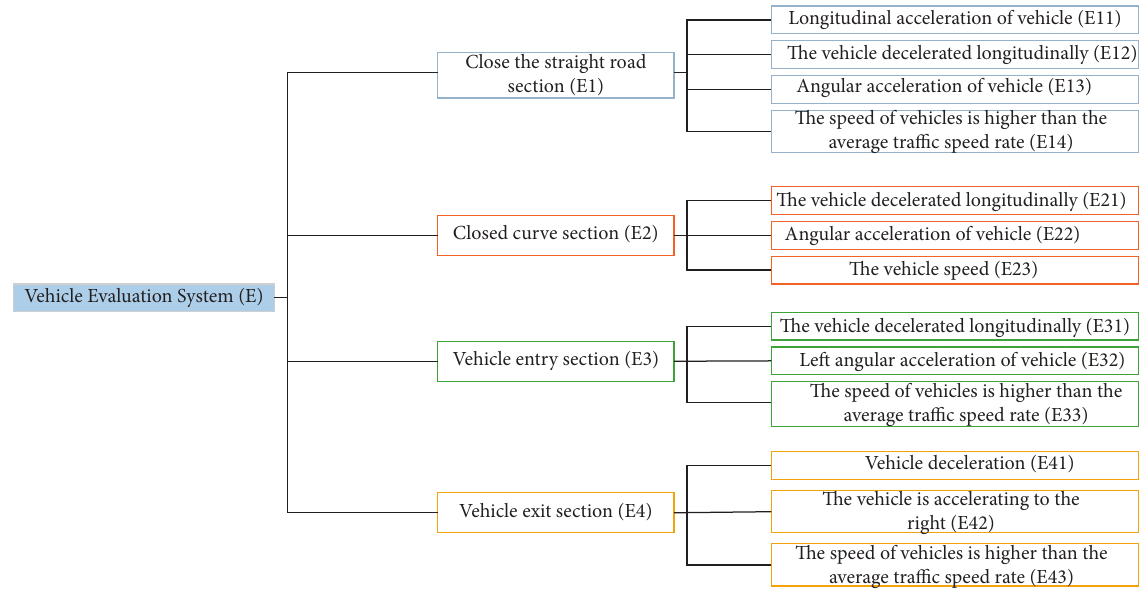
Figure 10: Vehicle behavior evaluation system. Table 3: Evaluation result of closed straight section.